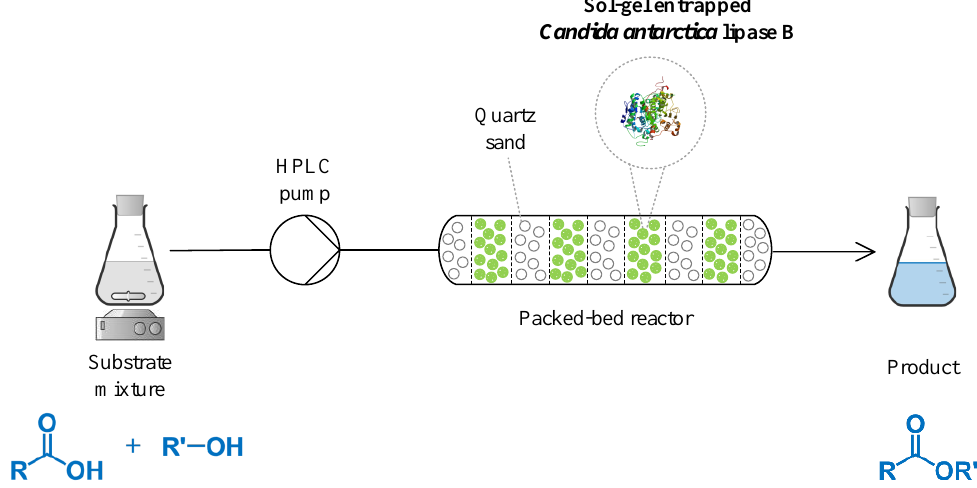
Figure 10. Continuous flow esterification of caproic acid and n -amyl alcohol, catalyzed by sol-gel- entrapped Candida antarctica B lipase (CalB-SG) in a solventless system. Table 5. Experimental setup of the continuous enzymatic synthesis parameters of n -amyl caproate catalyzed by sol-gel-entrapped Candida antarctica B lipase, along with the system responses. Experimental